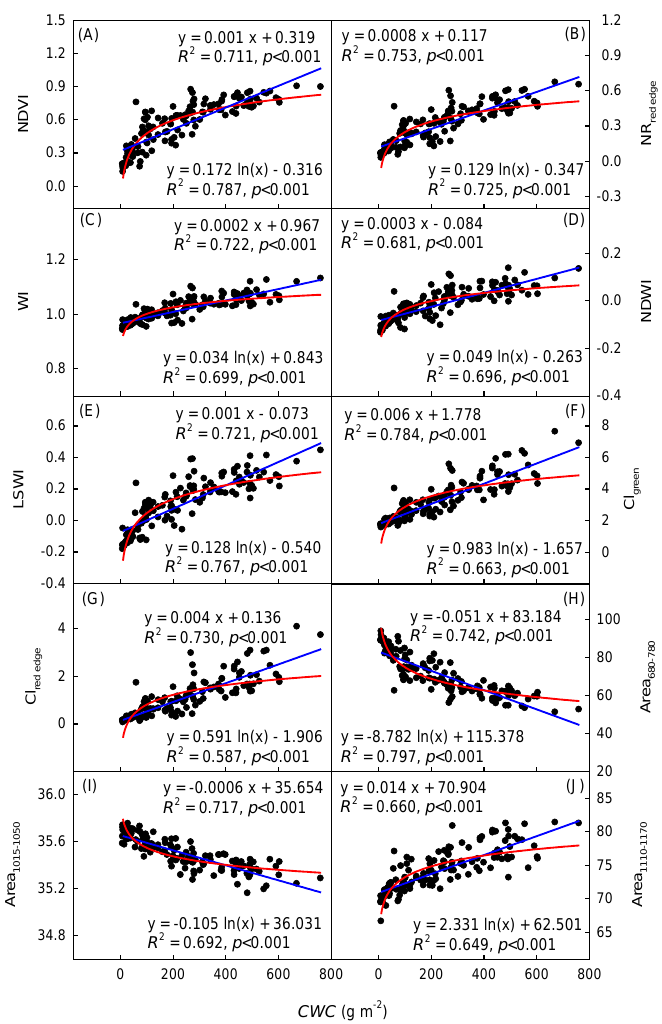
Figure 3. Relationships between ( A ) normalized difference vegetation index (NDVI), ( B ) red edge normalized ratio (NR red edge ), ( C ) water index (WI), ( D ) normalized difference water index (NDWI), ( E ) land surface water index (LSWI), ( F ) green chlorophyll index (CI green ), ( G ) red edge chlorophyll index (CI red edge ), ( H ) normalized red edge reflectance curve area (680–780 nm; Area 680–780 ), ( I ) normalized reflectance curve area (1015–1050 nm; Area 1015–1050 ), and ( J ) normalized reflectance curve area (1110–1170 nm; Area 1110–1170 ) vs. canopy water content ( CWC ) for maize during the growing seasons of